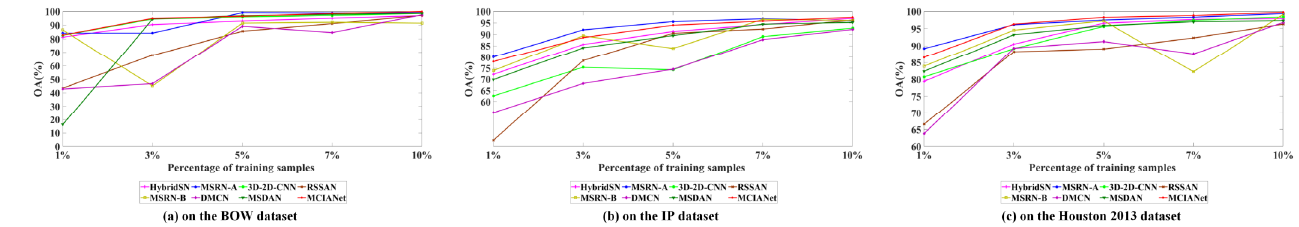
Figure 7. Generalization performance.